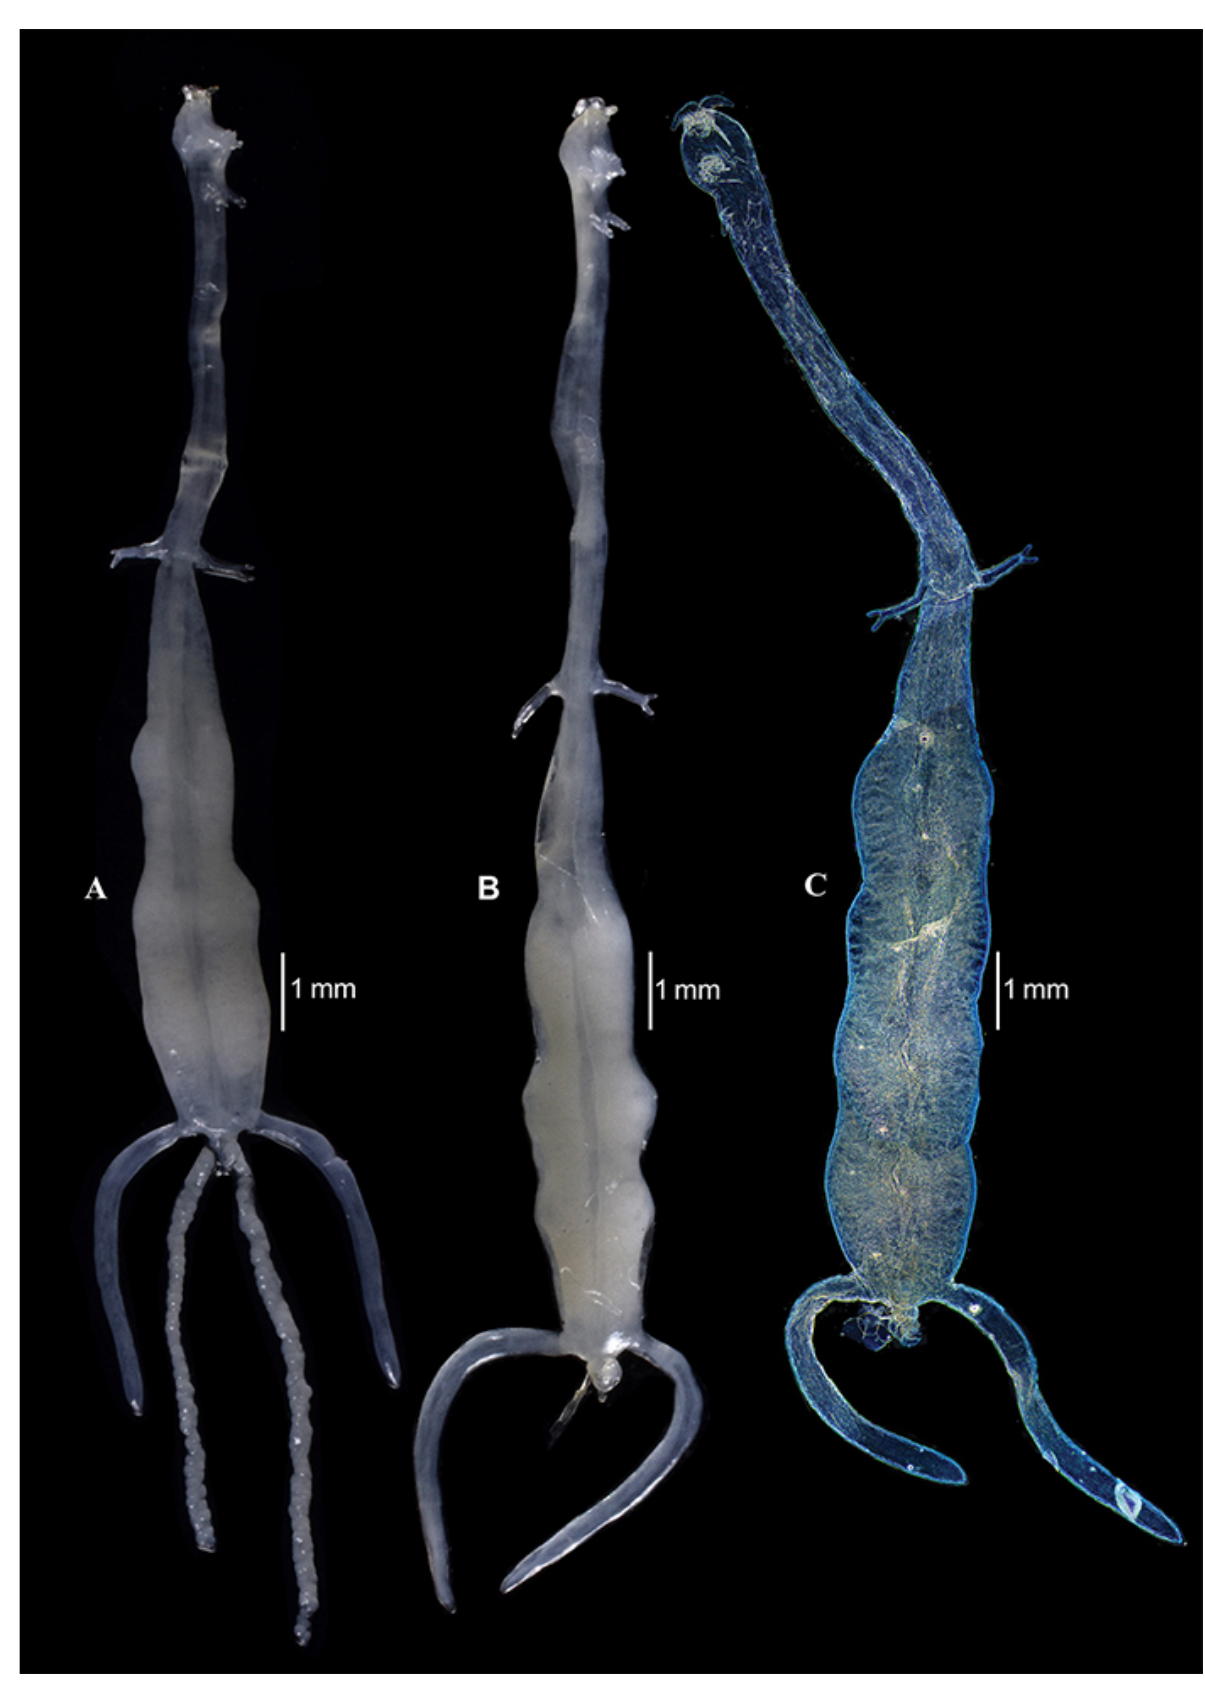
Figure 1. Acanthochondria krishnai sp. n., female from Uranoscopus guttatus Cuvier. A , B . Dorsal view. C . Ventral